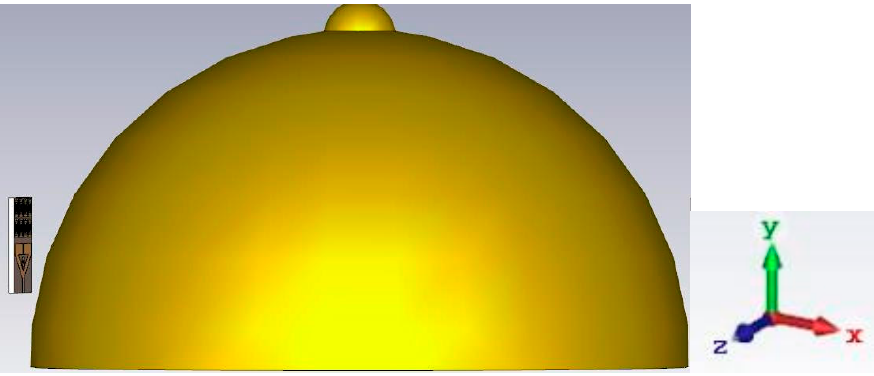
Figure 12. Cross section of breast model simulation setup.